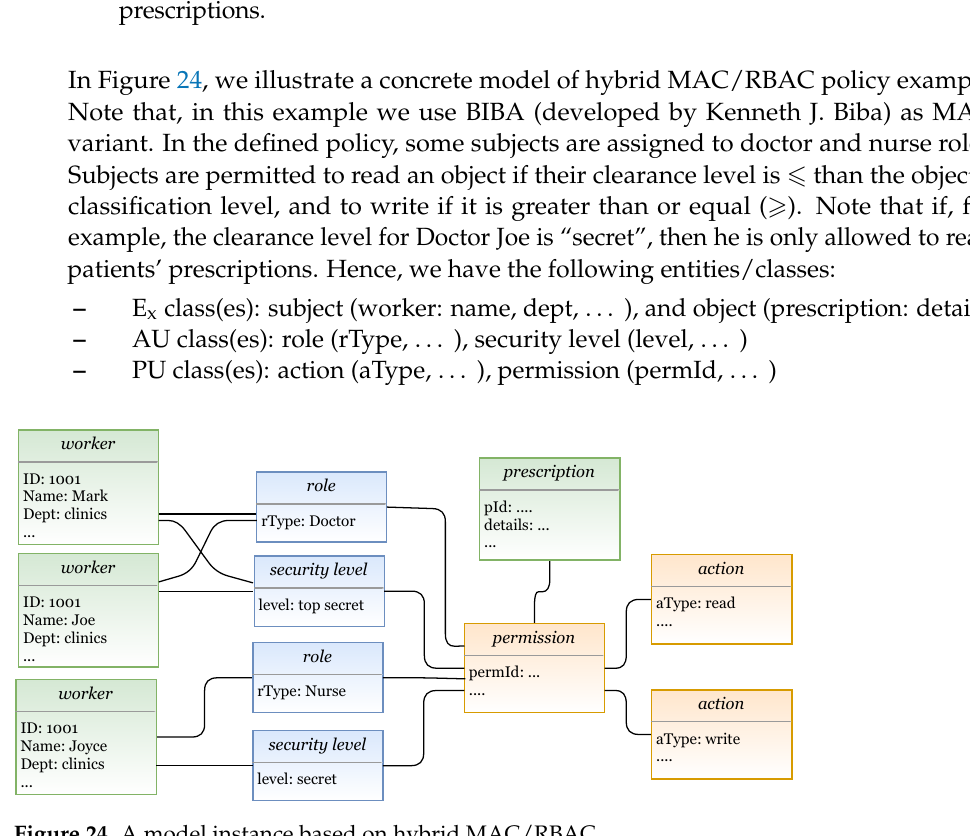
Figure 24. A model instance based on hybrid